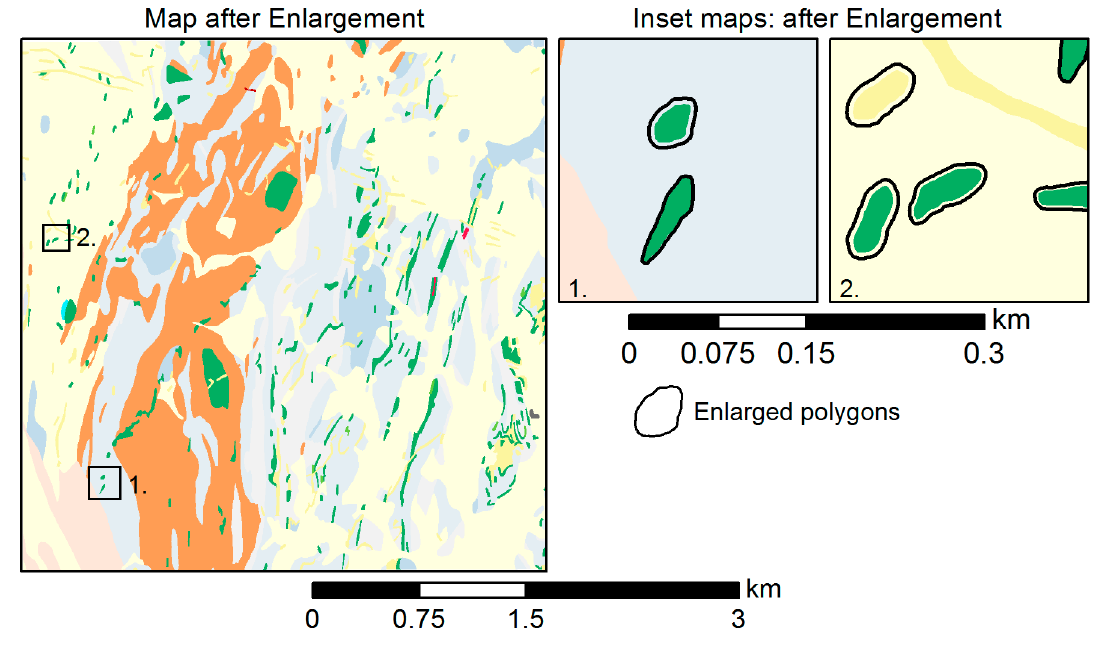
Figure 11. Part of the map after the enlargement of the number of polygons falling below the minimum area (MA) constraint that should be kept (n keep ), including two detailed examples illustrating enlarged polygons.